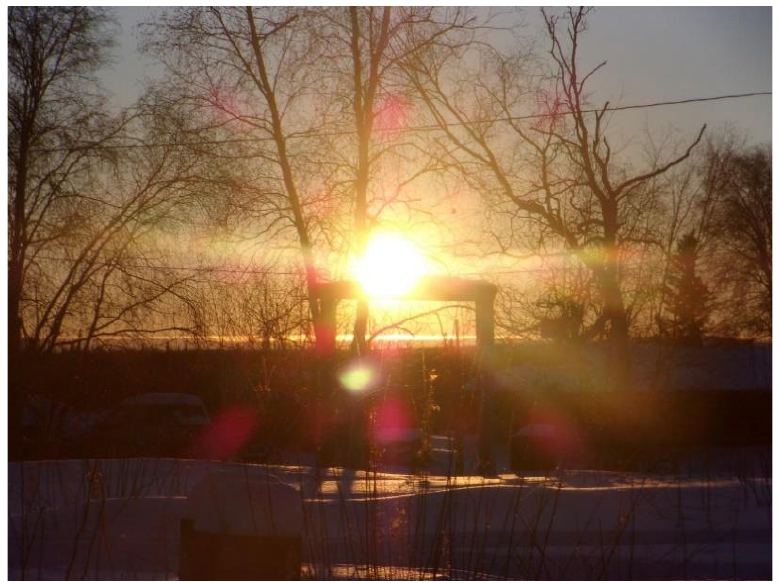
Figure 2. “Hello Sunset. The colorful sunset. It looks beautiful and colorful. The fish rack is holding the sun.”